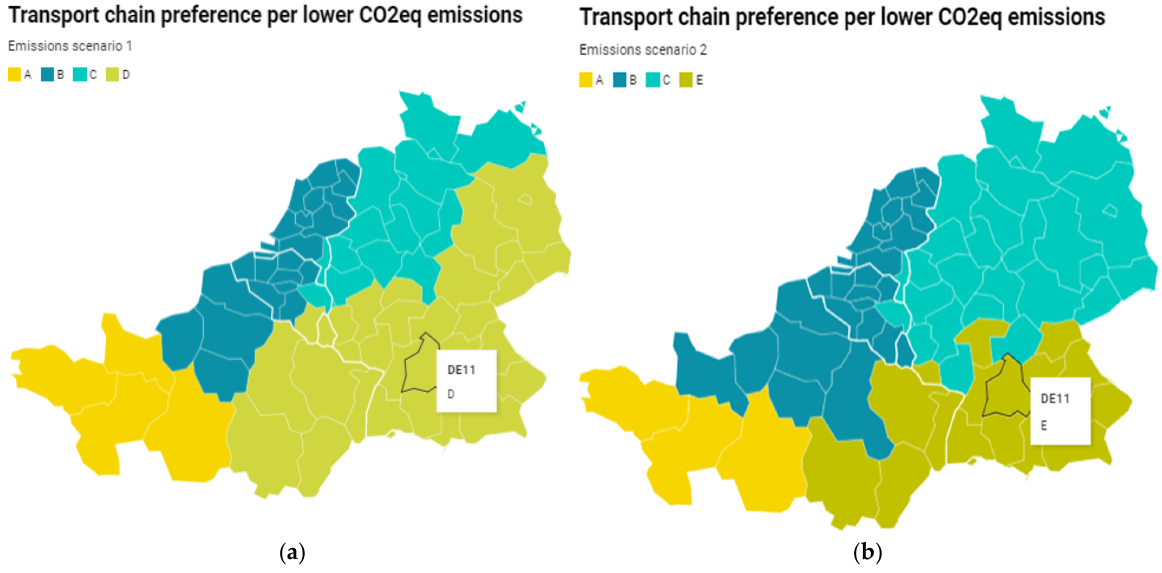
Figure 9. Transport chain preference per lower CO 2 ‐ eq emissions: ( a ) scenario 1; ( b ) scenario 2 (created with Datawrapper).